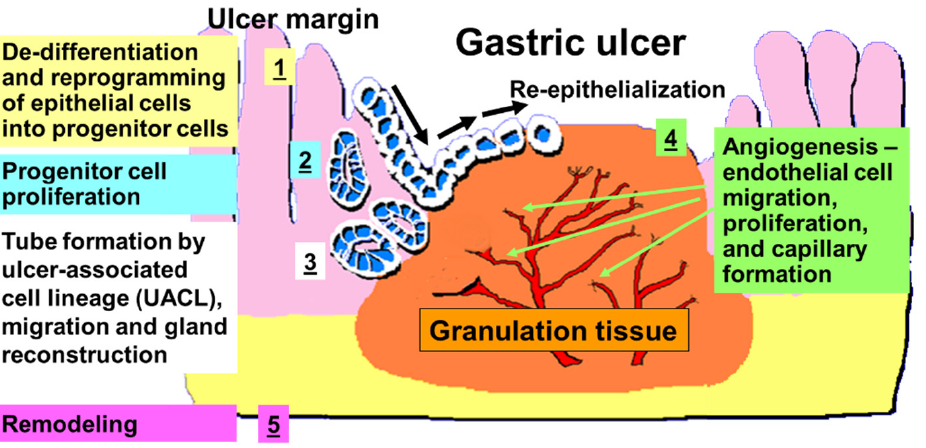
Figure 3. A diagrammatic representation of GU healing: re-epithelization, gland reconstruction, and angiogenesis. Modified from A. S. Tarnawski’s state-of-the-art presentation at EURO Symposium at the Pasteur Institute, Paris in 2005.